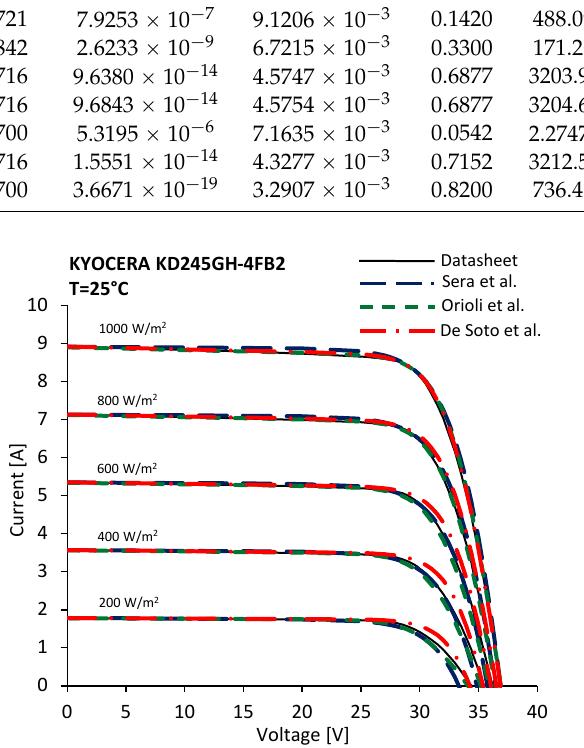
Figure 4. Comparison between the issued I-V characteristics of Kyocera KD245GH-4FB2 at T = 25 °C and the characteristics calculated by means of the Sera et al ., the Orioli et al . and the De Soto et al . models.